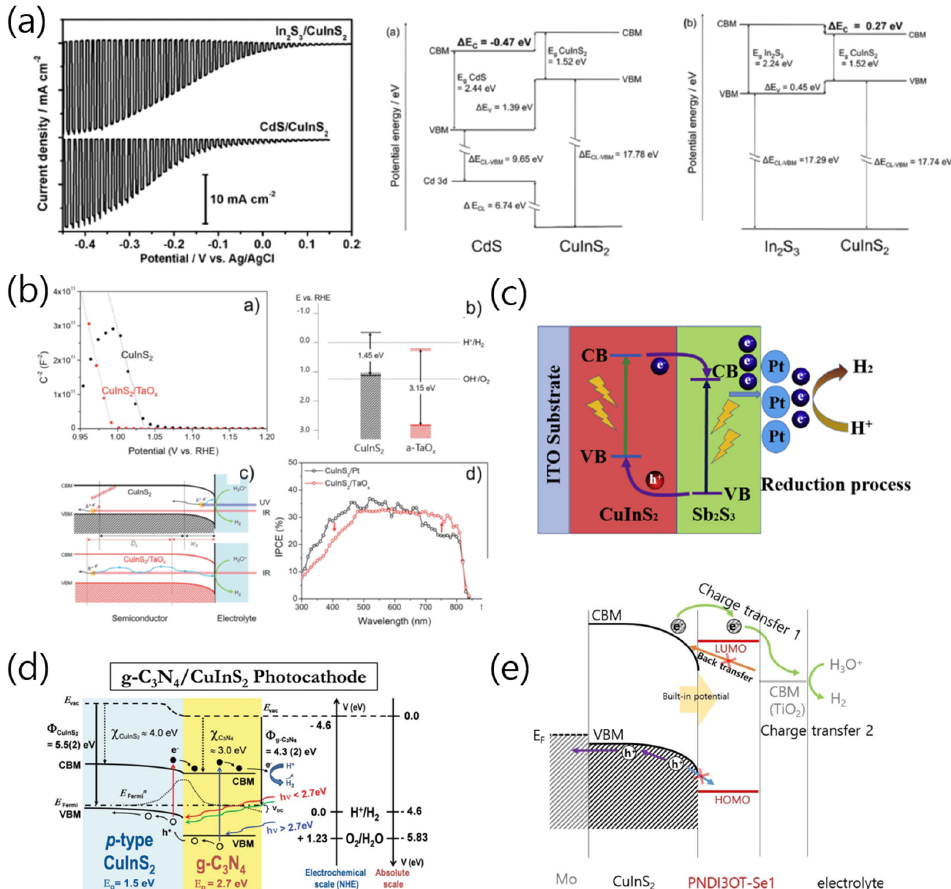
Figure 6. ( a ) Under chopped illumination of simulated sunlight (AM1.5), LSV profiles and differ- ence in energy levels between CdS and In 2 S 3 upon formation of a heterojunction with CuInS 2 for CuInS 2 /CdS and CuInS 2 /In 2 S 3 photocathodes using an aqueous solution 0.2 M Eu(NO 3 ) 3 (pH 4) [39]. ( b ) Mott–Schottky plots of CuInS 2 and CuInS 2 /TaO x , Fermi-level shift of the CuInS 2 /TaO x hetero- junction, a schematic diagram of band bending of CuInS 2 and CuInS 2 /TaO x photoelectrodes and incident-photon-to-electron conversion efficiency (IPCE) values for CuInS 2 /TaO x photocathodes [20]. ( c ) Schematic diagram of the CuInS 2 /Sb 2 S 3 /Pt photoelectrodes. This band alignment indicates the charge-transfer process [27]. ( d ) Proposed energy band diagram of the CuInS 2 /C 3 N 4 [33]. ( e ) Sche- matic energy diagrams of CuInS 2 /PNDI3OT-Se1-polymer heterojunctions, indicating charge trans- fer between semiconductors [48]. Reproduced from ref. [39] with permission from the American Chemical Society. Reproduced from ref. [20,33,48] with permission from the Royal Society of Chem- istry. Reproduced from ref. [27] with permission from Elsevier.